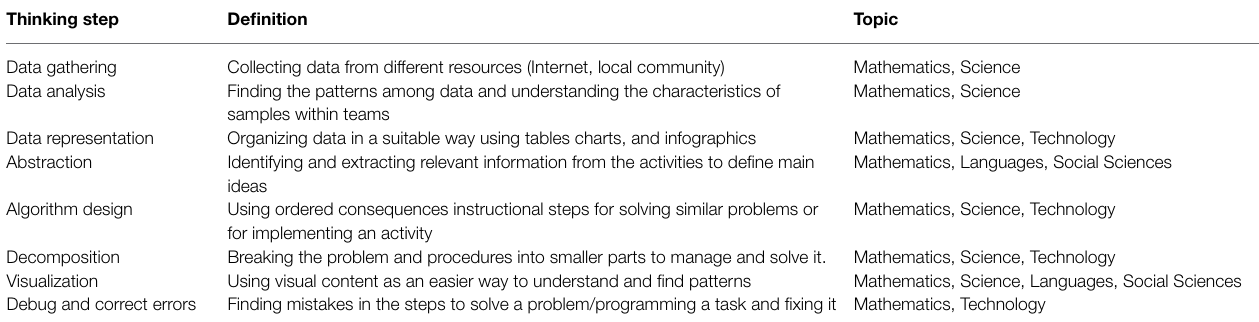
TABLE 2 | Thinking steps used by teachers in their